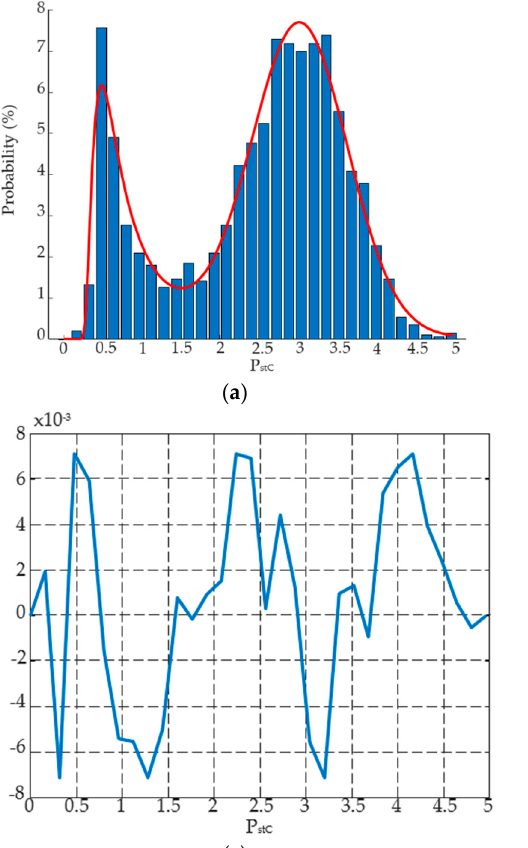
values P st and determined distributions ( c , d ).